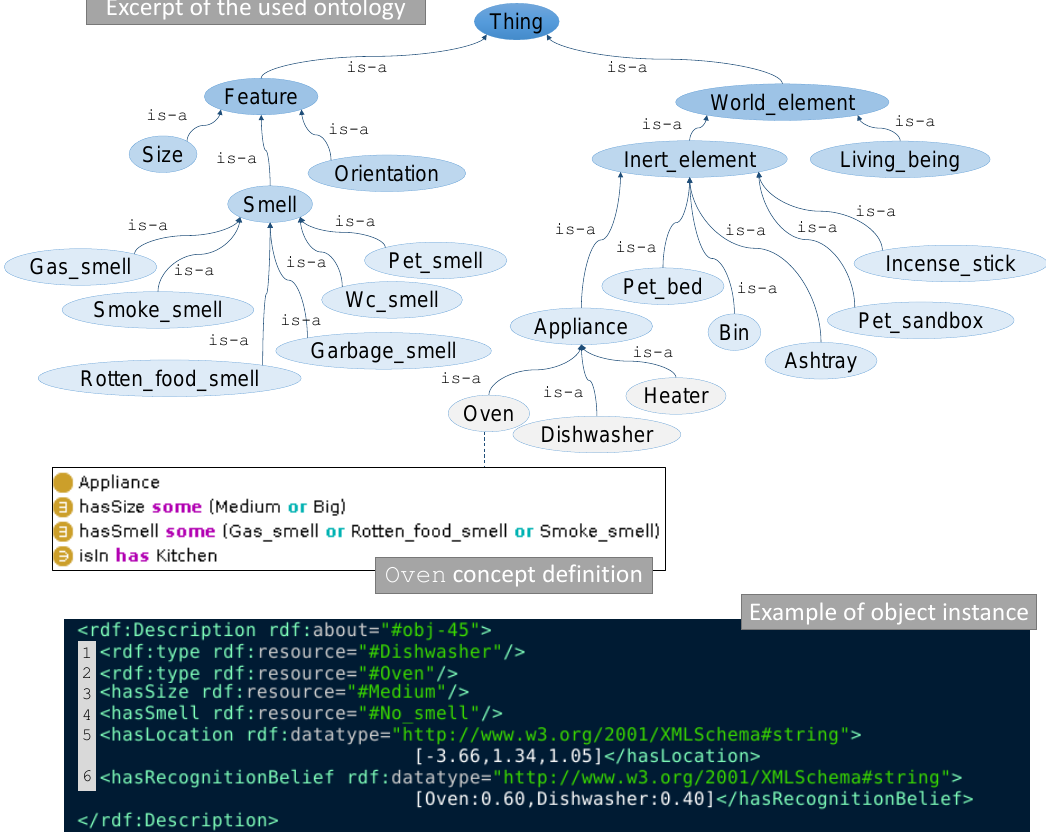
Figure 2. ( Top ) Excerpt of the ontology used in this work, whose hierarchy is built by means of is-a predicates, e.g., is-a(Smell,Feature) . ( Middle ) Simplified definition of the concept Oven